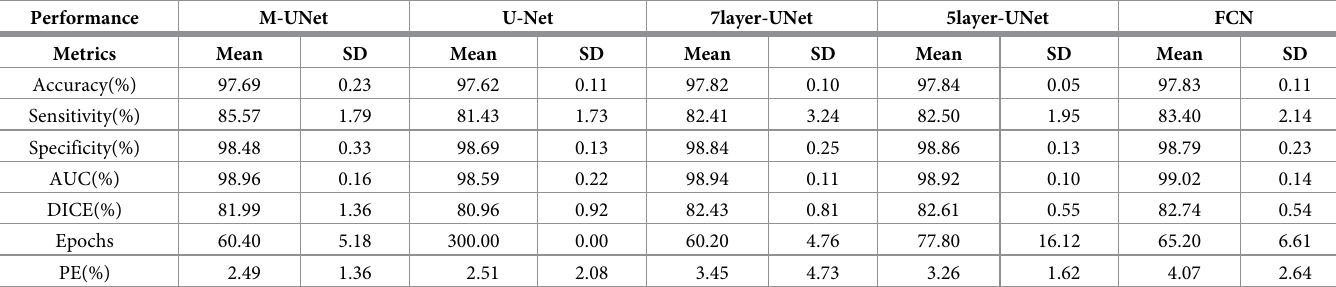
Table 3. Cell segmentation results on the first testing region for specimen 1.